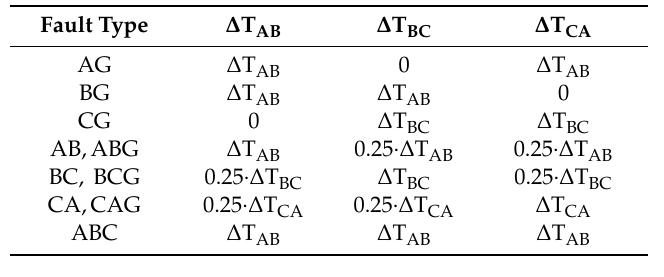
Table 2. Margin of action for AB and ABG faults [20].